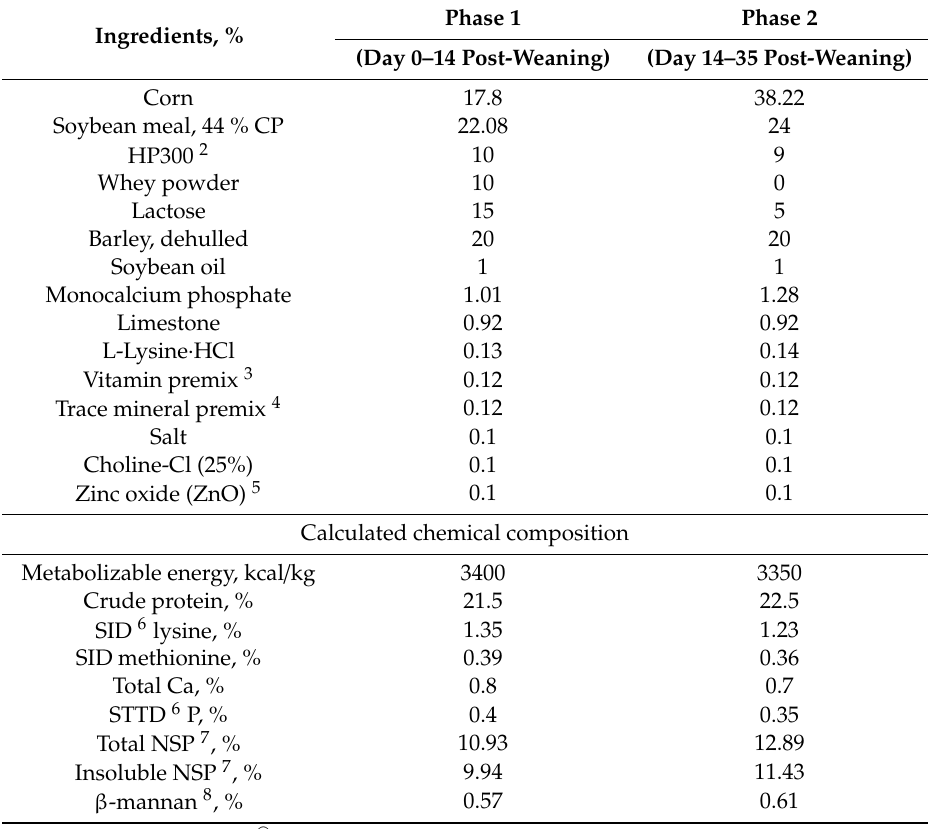
Table 1. Experimental diet formulation and chemical composition of the basal diets (as-fed basis) 1 . Ingredients, %